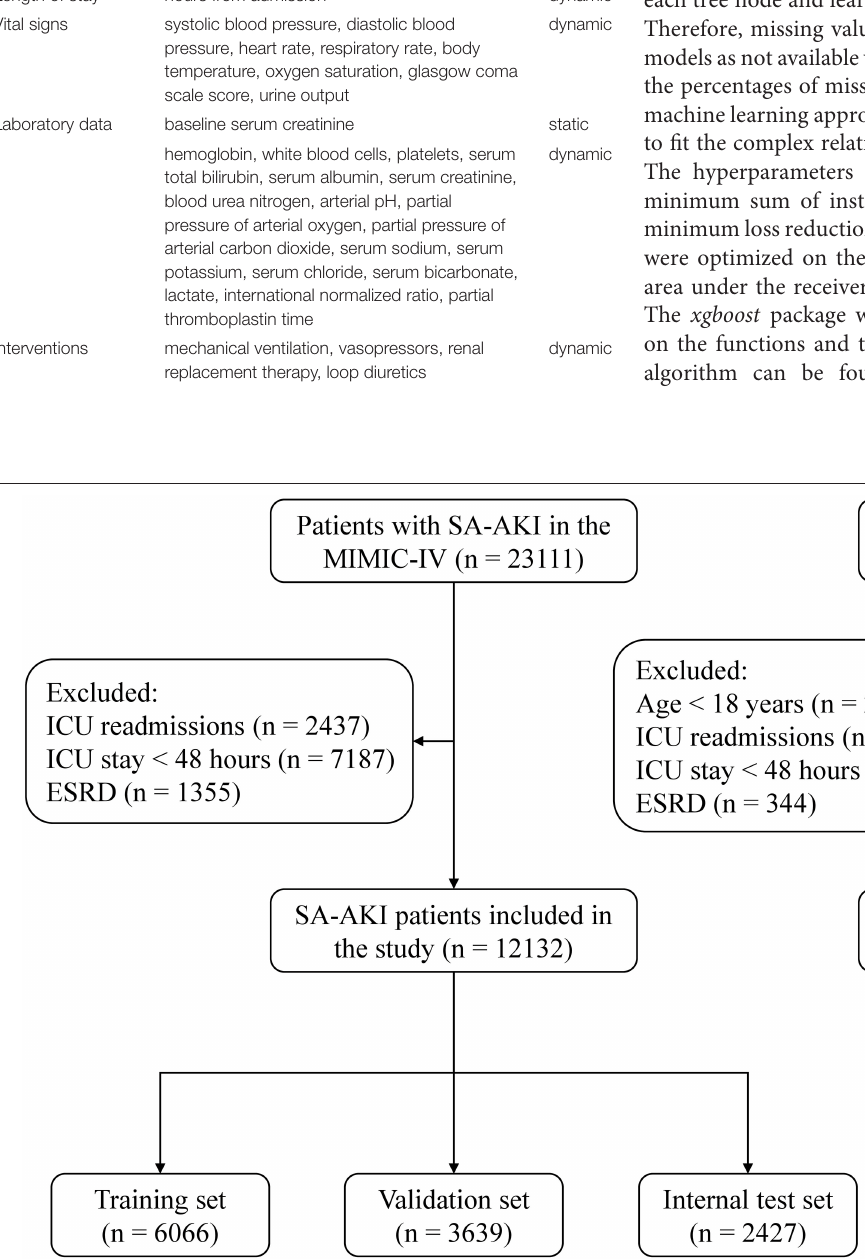
Frontiers in Medicine |